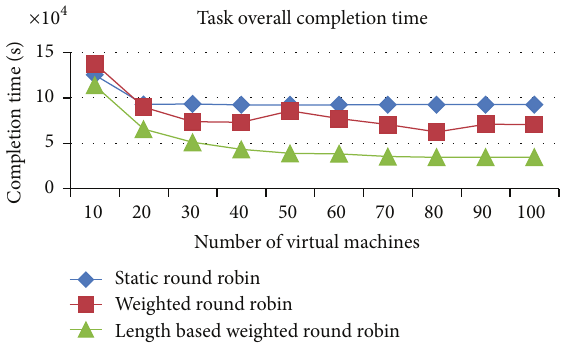
Figure 11: Execution completion time (space shared).